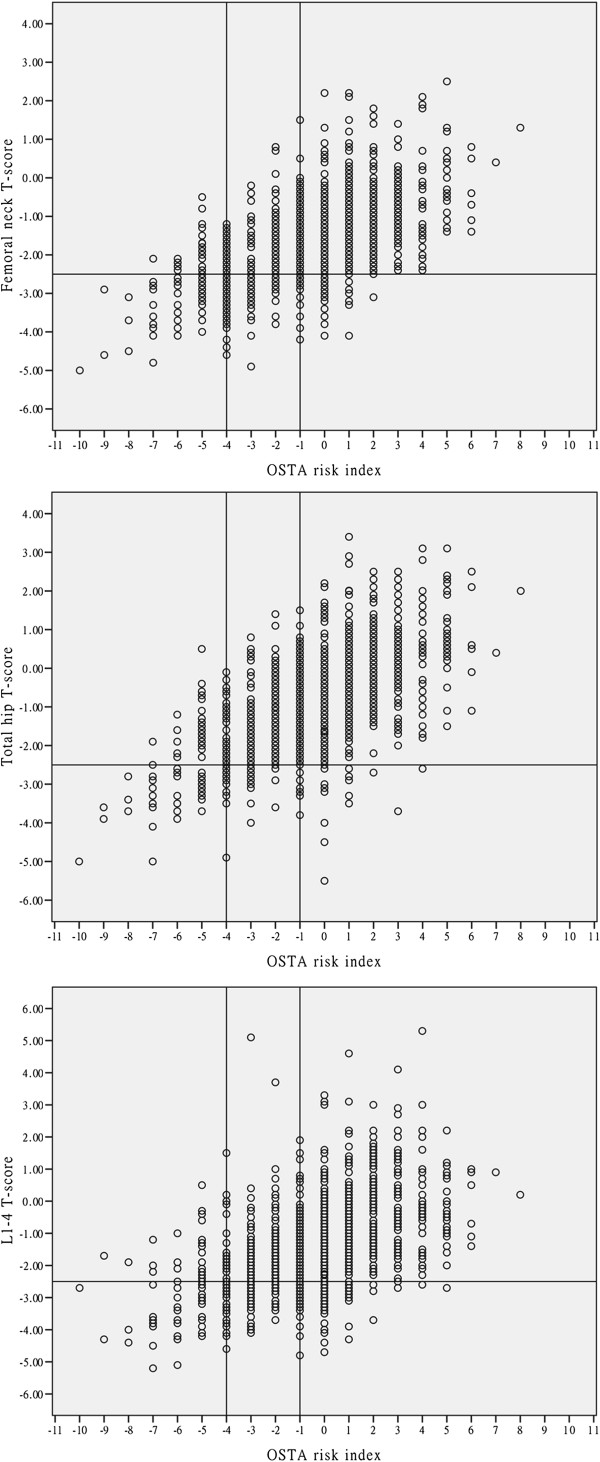
Distribution of T-scores by OSTA index value. The horizontal line demarcates a T-score of -2.5 and the vertical lines mark the OSTA risk index cutoffs of -1 and -4.